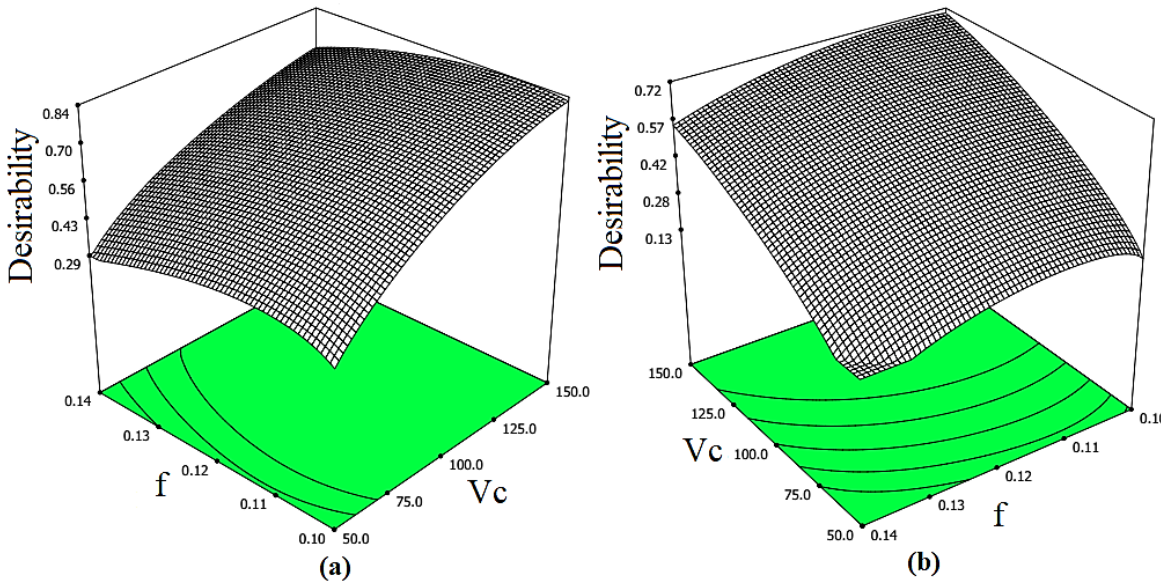
Figure 11. 3D Plot of desirability for the optimal solutions of ( a ) Case 1 and ( b ) Case 2. Table 10. Optimal combination of process parameters with their respective responses.